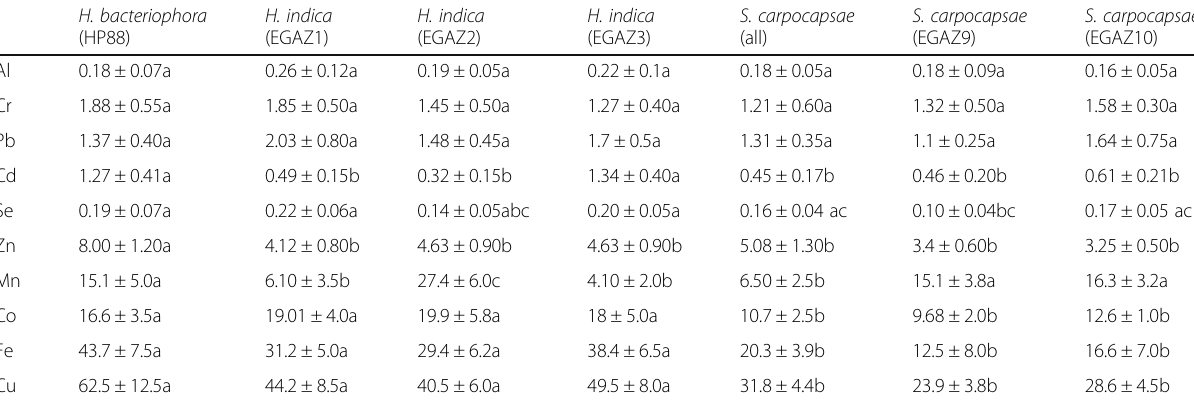
Table 5 Concentration of elements in infective juveniles (IJ) of the studied nematode species and/or isolates (concentration reported as mean picograms per IJ ± standard deviation)